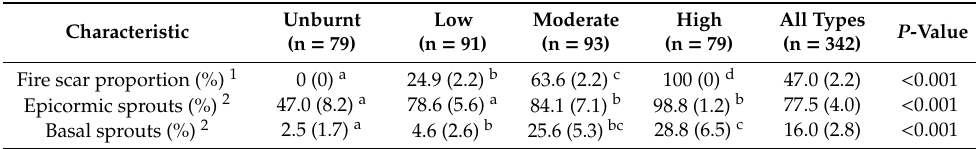
Table 2. Characterization of 342 field-measured trees by fire-severity types (means + SE). P -values indicate the significance of the fire-severity e ff ect in a linear mixed e ff ects model, and di ff erent superscript letters indicate significant di ff erences among fire-severity types (Fisher’s LSD Test).